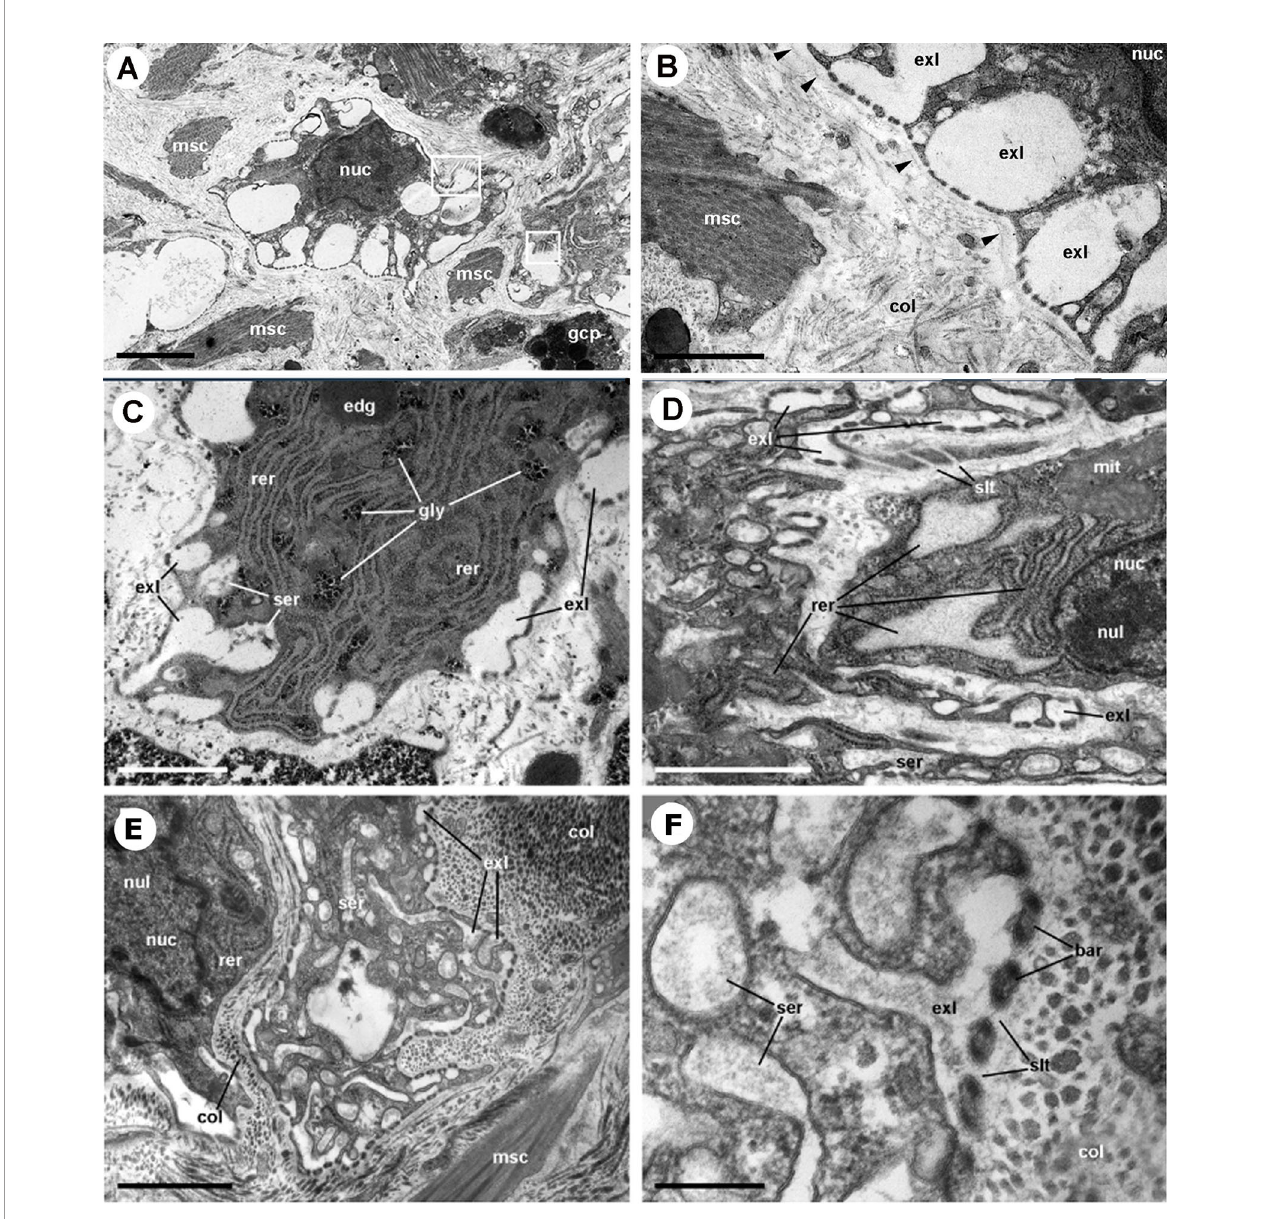
FIGURE 10 | Rhogocytes in the lung (under TEM). (A) A rhogocyte and the cytoplasmic extension of another one, showing the extracellular lacunae with the characteristic “ slit apparatus ” ; they are surrounded by a lamina densa and extracellular matrix where muscle fi bers and storage cells are embedded. Most components of the slit apparatus (i.e., bars and slits) appear sectioned transversally, but the two dashed boxes show some longitudinally sectioned. Scale bar represents 2 µm. (B) Detail of the extracellular lacunae of the same rhogocyte. Arrowheads indicate the extracellular matrix that surrounds the rhogocyte. Scale bar represents 1 µm. (C) Rough endoplasmic reticulum with interspersed glycogen clumps; pro fi les of the smooth endoplasmic reticulum are also seen in the vicinity of the extracellular lacunae. (D) Wide cisternae of the rough endoplasmic reticulum, and a large nucleolus within an oval nucleus; cytoplasmic extensions found in the vicinity (probably from other rhogocytes) contain rough endoplasmic reticulum and extracellular lacunae. (E) A cytoplasmic region showing a wide cistern of the smooth endoplasmic reticulum as wells as multiple tubuli, some of which connect with extracellular lacunae. (F) Close-up of a connection of the smooth endoplasmic reticulum with an extracellular lacuna; the slit apparatus opens to a region of packed collagen fi bers. BAR, bar of the slit apparatus; COL, collagen matrix; EDG, electron-dense globule; EXL, extracellular lacunae; GCP, glial cell process; GLY, glycogen; MIT, mitochondria; MSC, muscle cell; NUC, nucleus; NUL, nucleolus; RER, rough endoplasmic reticulum; SER, smooth endoplasmic reticulum; SLT, slit of the slit apparatus. Scale bars represent: (A) 2 µm; (B – D) 1 µm; (E) 500 nm; (F) 200 nm. From